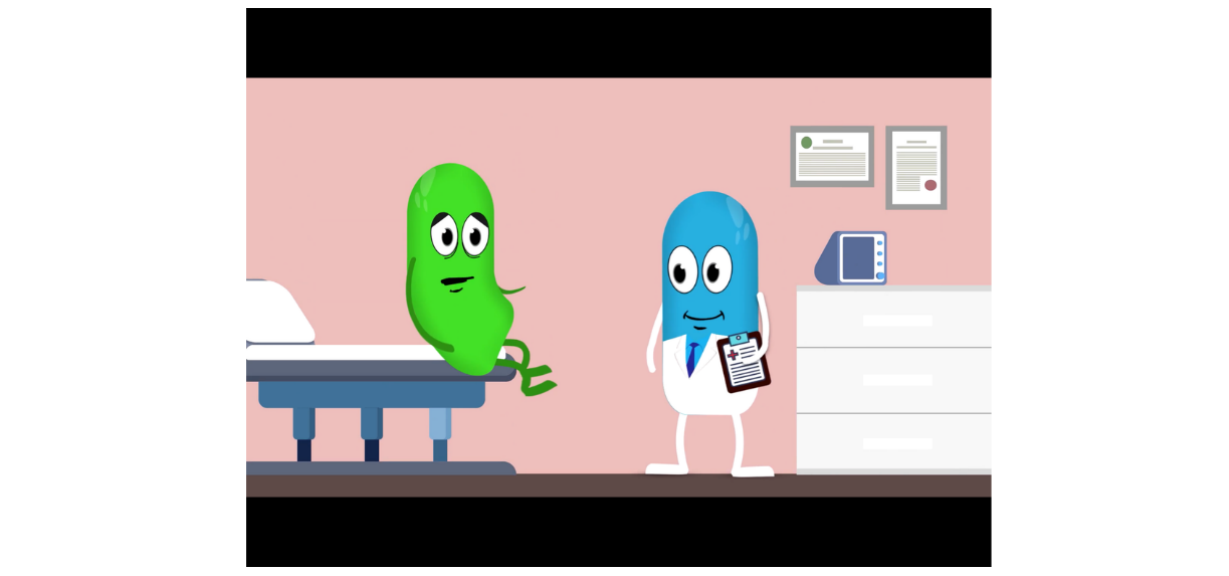
Figure 2. Storytelling 4 Empowerment animated storytelling